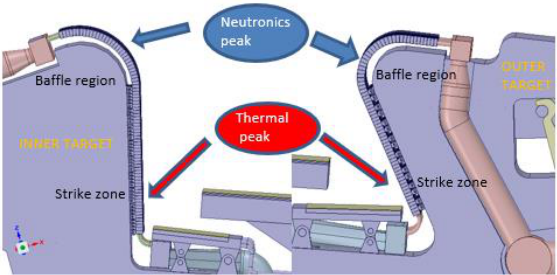
Figure 29. Poloidal profiles of the inner ( left ) and outer ( right ) target, highlighting the neutronics and thermal peak area.